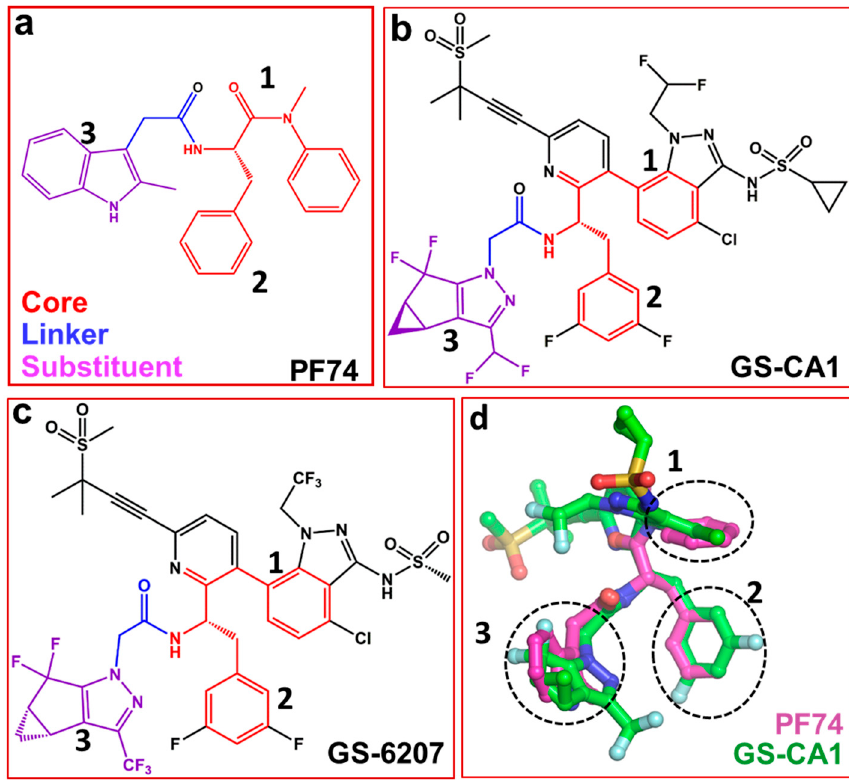
Figure 2. Structures of PF74 and GS-CA compounds. ( a ) PF74 can be divided into three components: polyphenyl core (red), linker (blue) and substituent (violet). Numbers 1, 2 and 3 represent three ring structures in PF74. Panels ( b ) and ( c ) show the chemical structure of GS-CA1 and GS-6207 compounds, respectively. Chemical moieties colored red, blue and violet correspond to those in PF74 (panel a). ( d ) Superposition of PF74 and GS-CA1. Dotted circles show the superposition of three ring structures present in PF74, GS-CA1 and GS-6207.